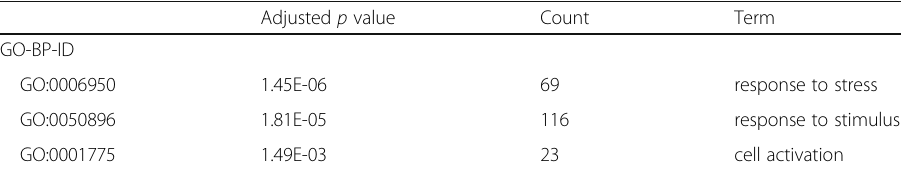
Table 4 GO biological processes for significantly changed genes in comparison